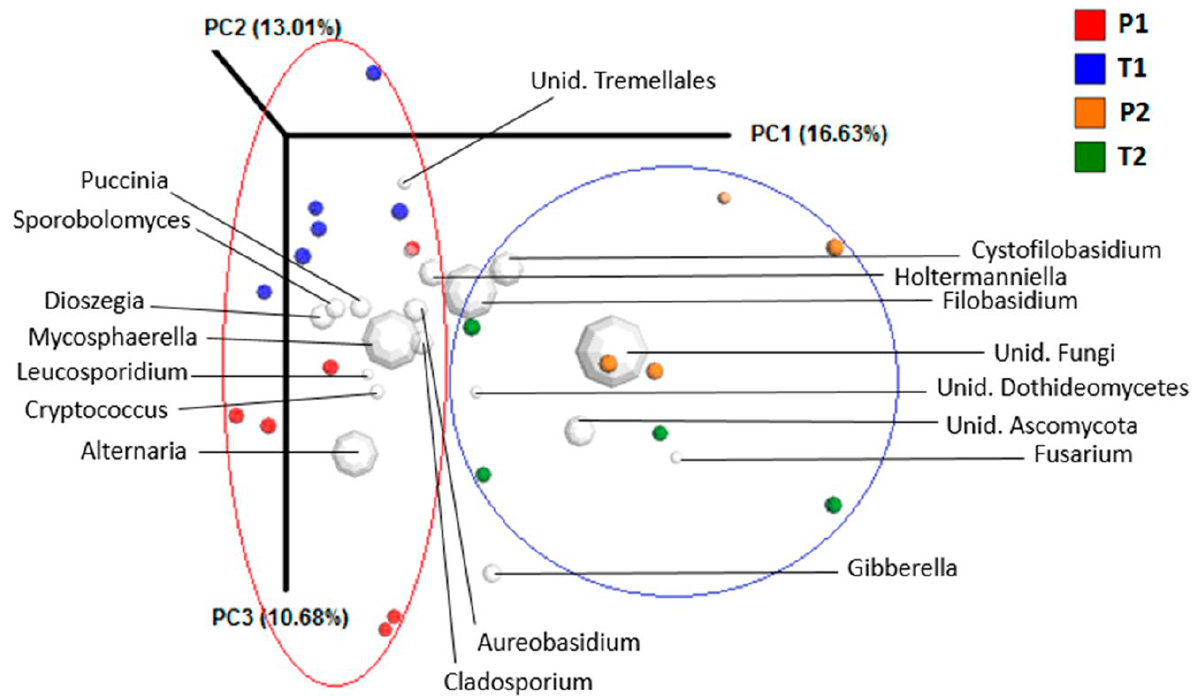
Figure 4. Principal Coordinates Analysis (PCoA). Integration of taxonomy in the PCoA graph showing the distribution of the 18 most abundant endophytic fungal genera among the four sample categories (white symbols). The taxonomic plot weight and the distance from the sample plots are proportional to the relative abundance of each genus. Red circle: cluster of Field 1 samples; blue circle: cluster of Field 2 samples. The different coloured symbols indicate the sample categories: P1 = Perciasacchi from Field 1; T1 = Tumminia from Field 1; P2 = Perciasacchi from Field 2; and T2 = Tumminia from Field 2.